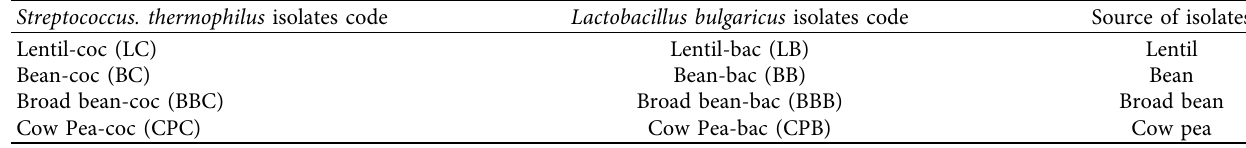
Table 1: Code of S. thermophilus and L. bulgarıcus isolate and sources.